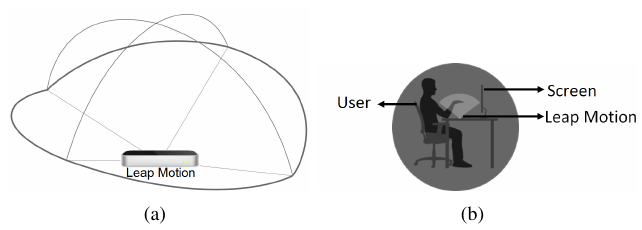
Fig. 2: In (a), the Leap Motion ’s sensor area; and, in (b), the Leap Motion positioned between the keyboard and the